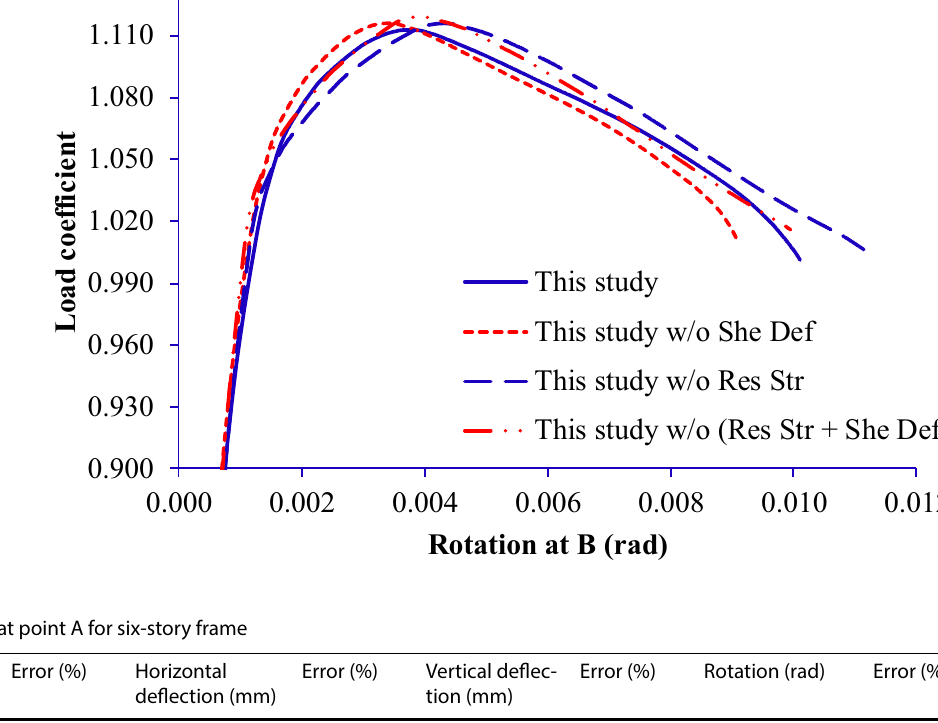
Table 2 Deflection at limit load at point A for six-story frame